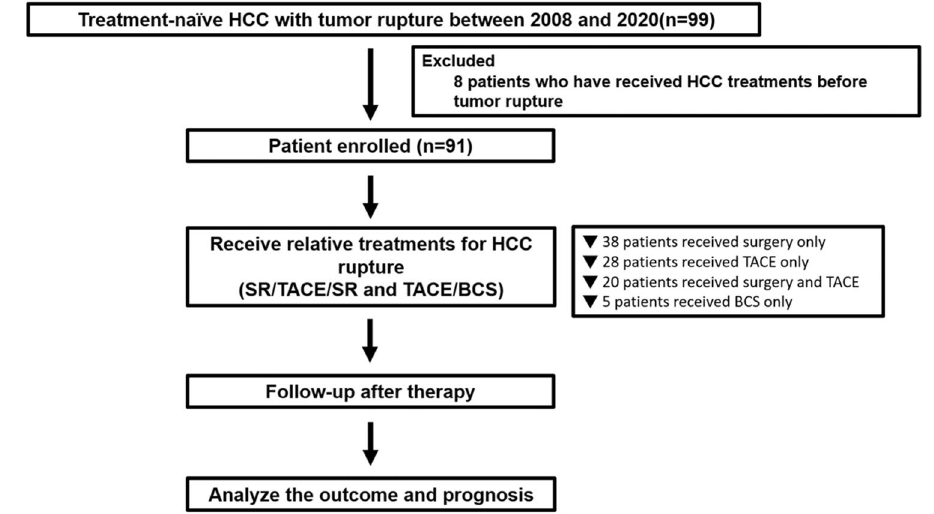
Figure 1. Study flow chart.